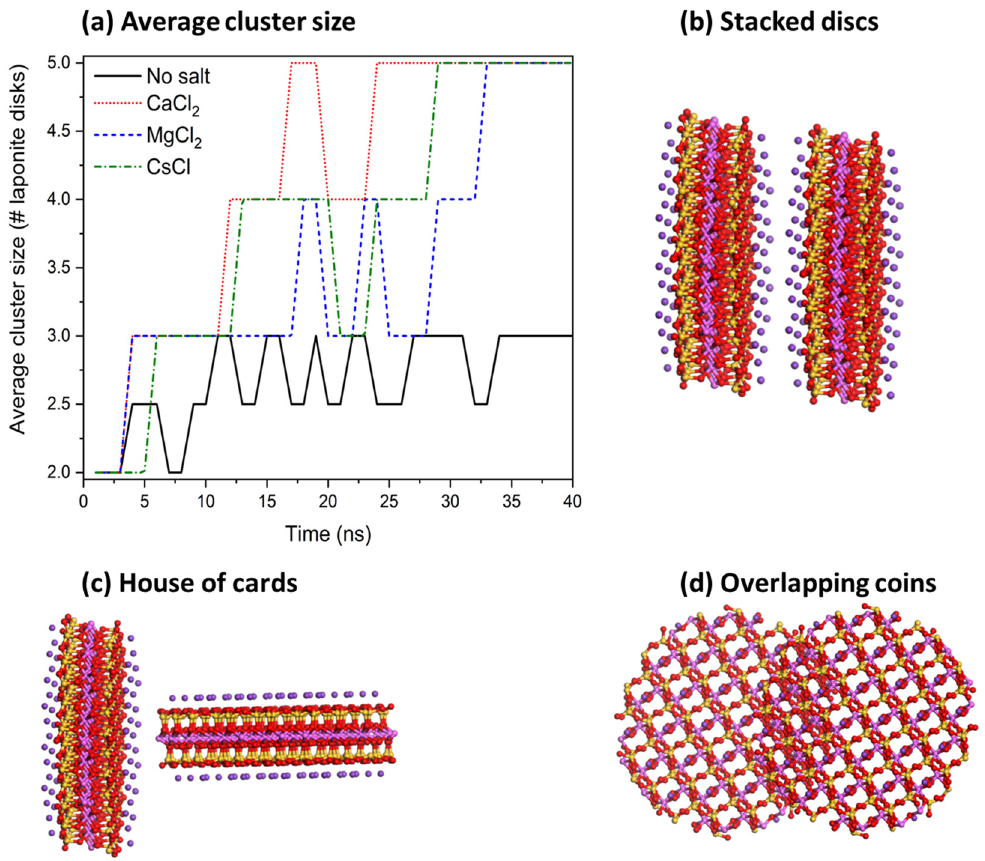
Figure 5. ( a ) The self-assembly profile of the laponite disks as a function of the simulation time in the absence and presence of 5 mM of CaCl 2 , CsCl and MgCl 2 . The self-assembly profiles are represented by the average cluster size. Snapshots of the aggregated disks at ( b ) stacked disks, ( c ) house of cards and ( d ) overlapping coin configurations.